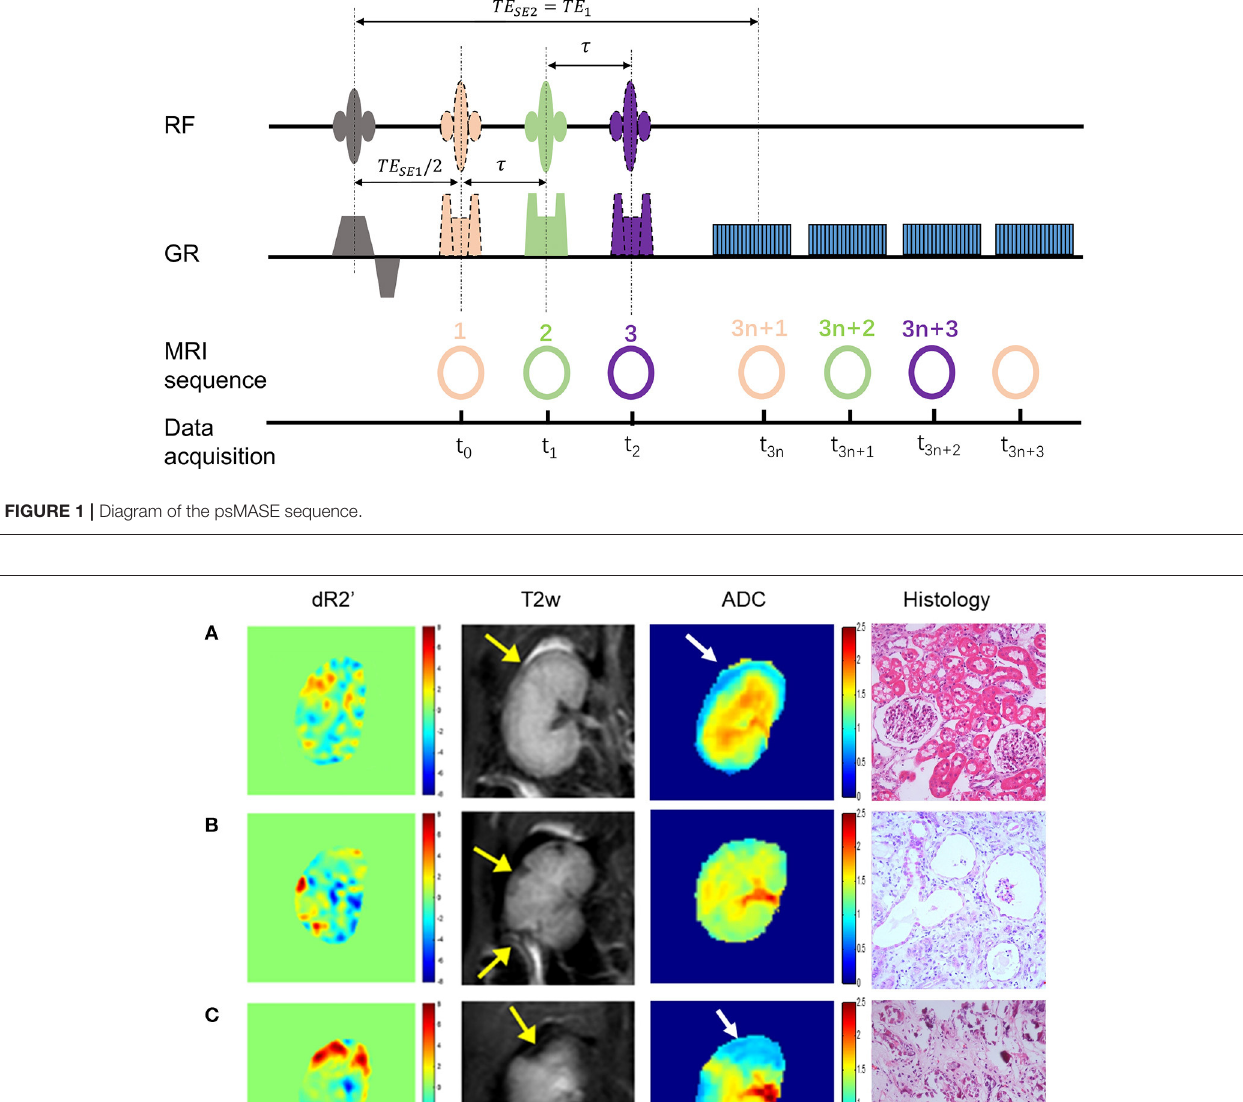
maps were generated as reported previously (12), and the changes of R2’ (dR2’) during room air and carbogen were